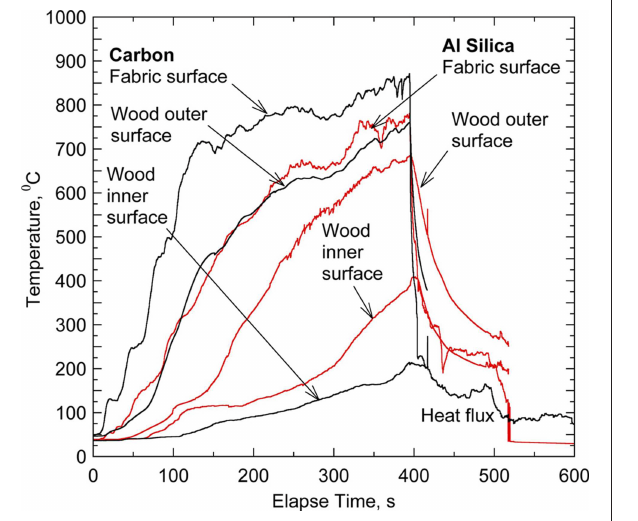
TABLE 4 | Fire blanket materials tested in prescribed burns.